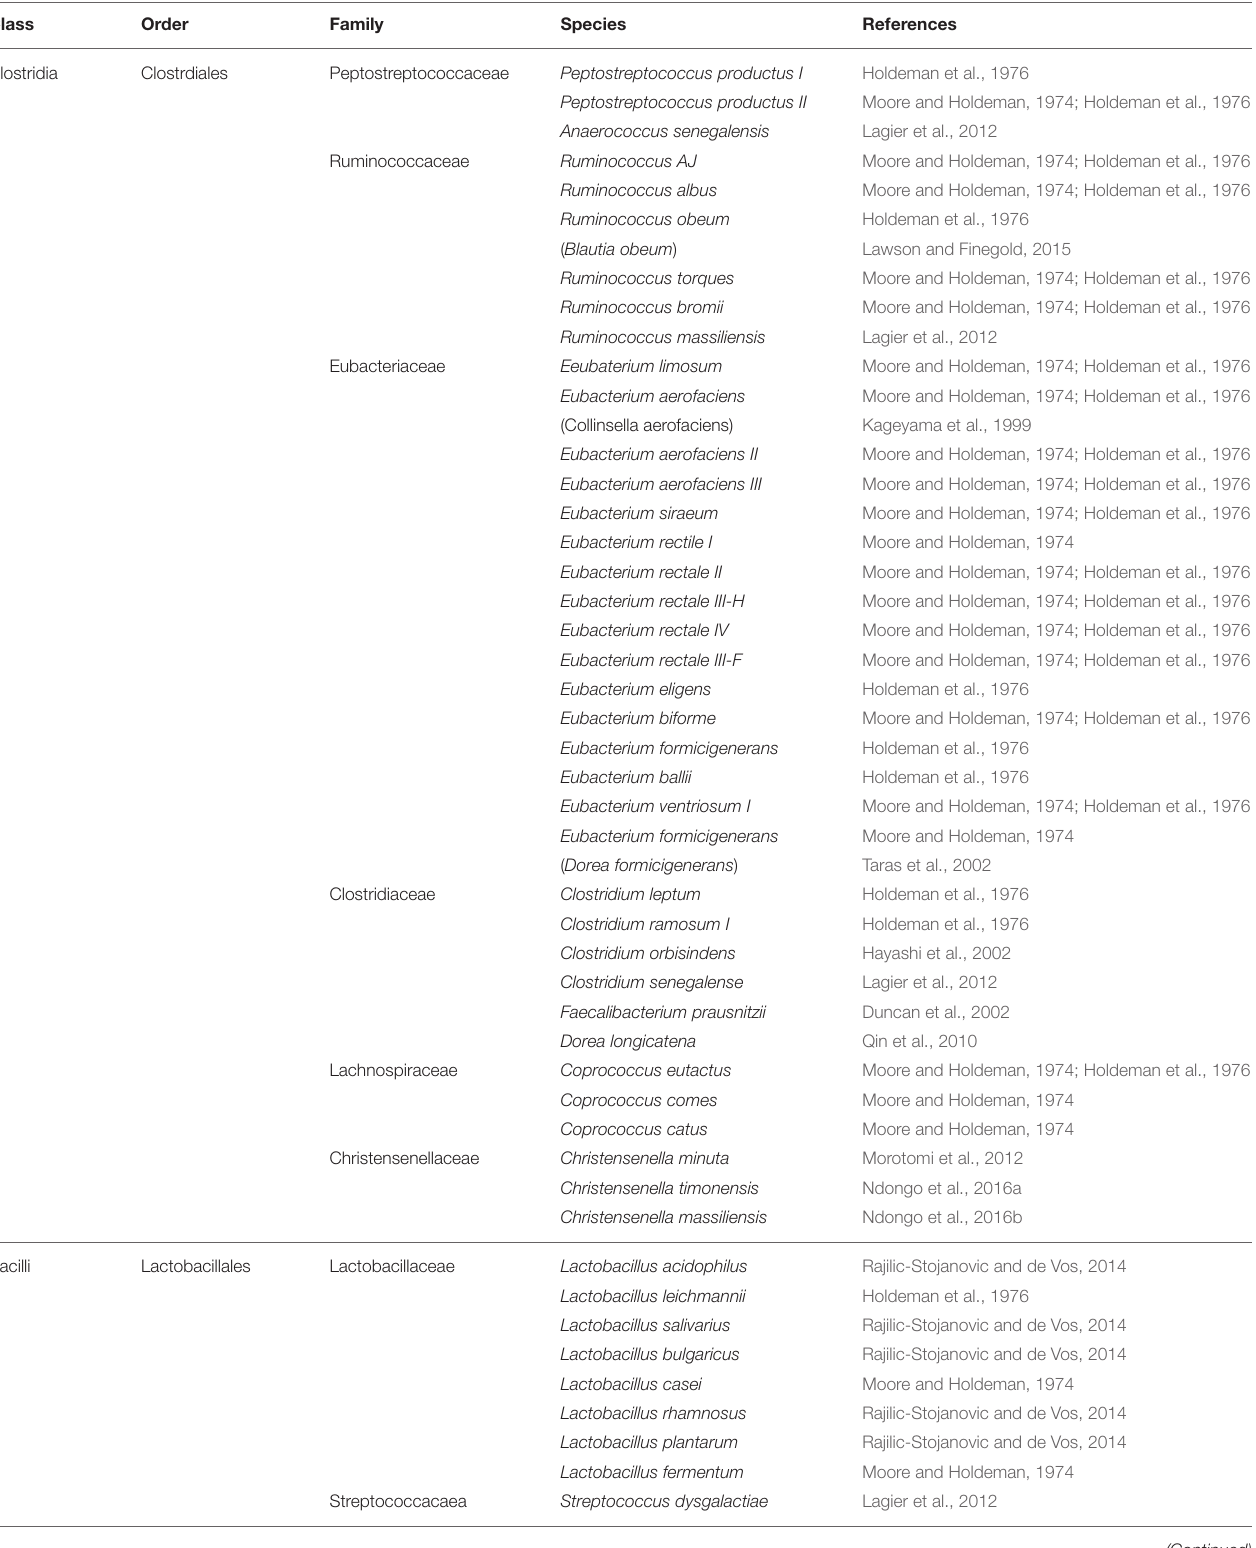
TABLE 1 | Firmicutes phylum (class, order, family) and major species constituting the microbiota in healthy human gut.